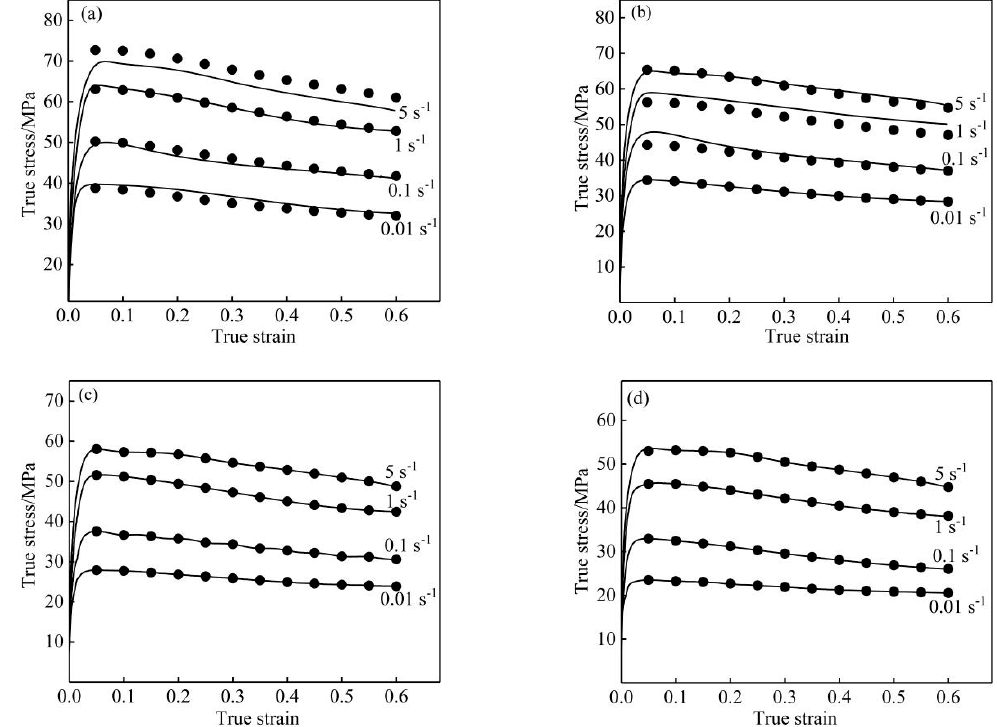
Figure 8. Comparison between experimental and predicted stress of nano-SiCp/Al-Si composites at different deformation conditions: ( a ) 470 °C; ( b ) 490 °C; ( c ) 510 °C; ( d ) 530 °C .